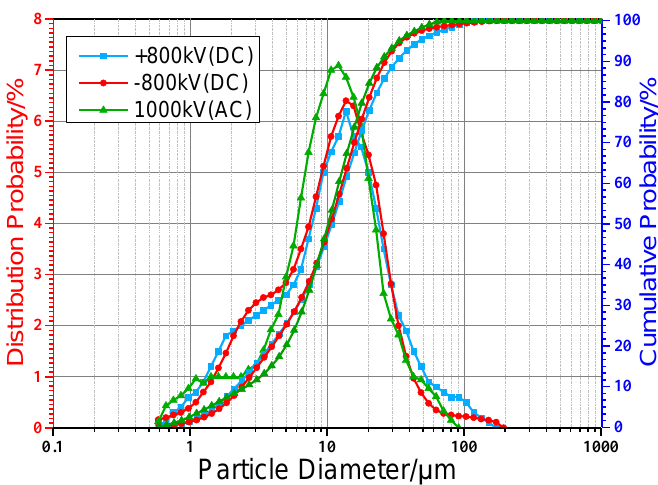
Figure 2. Size distribution diagram of typical contaminated particle samples.